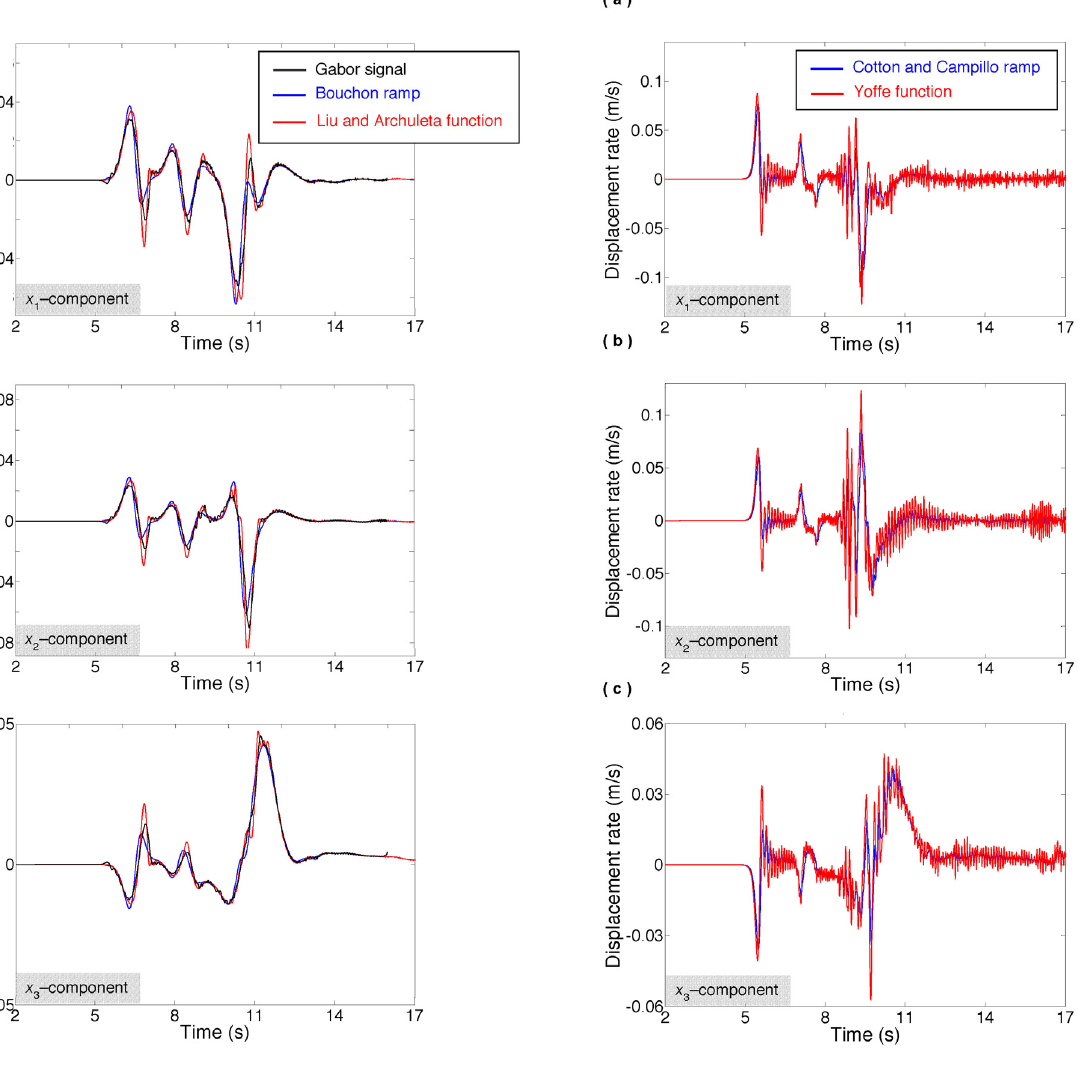
Figure 2 (left panels). Time evolution, low-passed at 8 Hz, of the displacement rate at a free surface receiver R located at a distance of 25 km from the epicenter and 20 km from the fault trace. The location of R and the assumed fault geometry are reported in Figure 14a of Bizzarri [2011b]. Different colors define different slip velocity functions (Gabor signal, Equation (3), Bouchon ramp, Equation (4) and Liu and Archuleta function, Equation (8)). (a) Fault-parallel component (namely, V ). (b) Fault-normal component (namely, V ). (c) Vertical component (namely, V ). Fig- 1 2 3 ure 3 (right panels). The same as Figure 2, but now we consider the Cotton and Campillo ramp (Equation (5)) and the Yoffe function (Equation